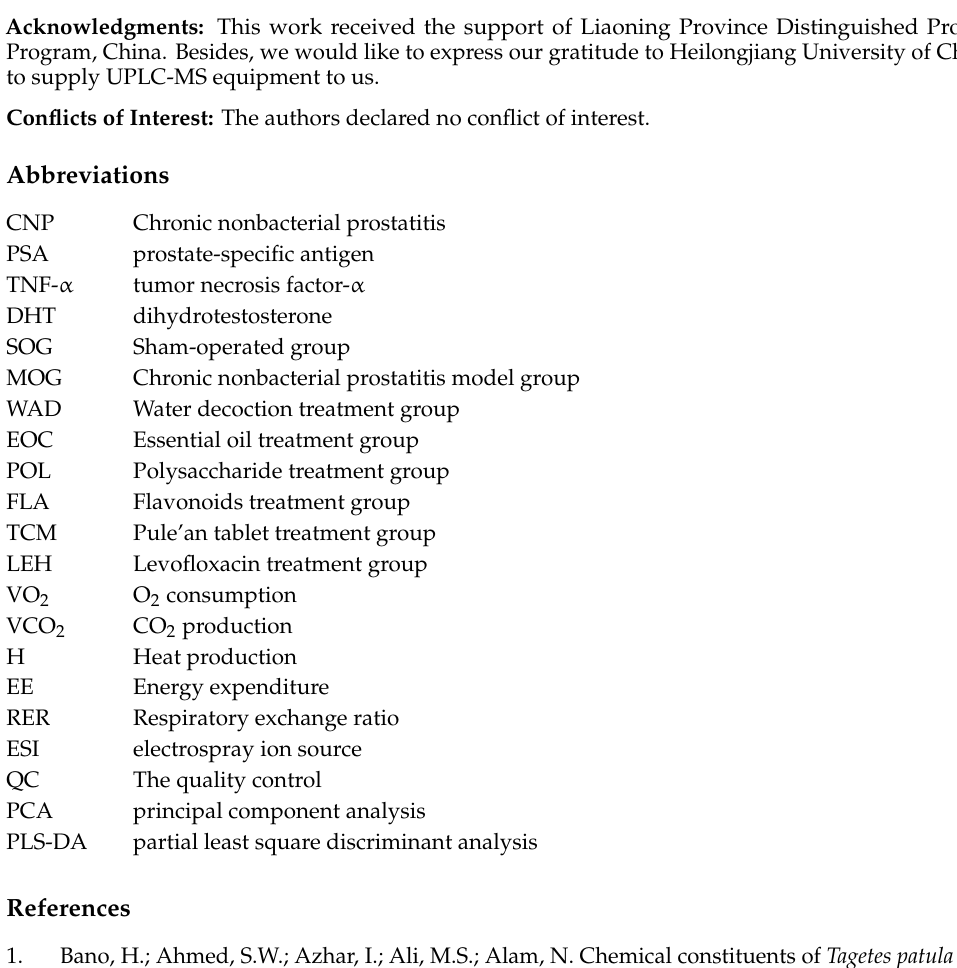
Figure S1: HPLC fingerprint of water decoction (a), supernatant (b) and essential oil (c) fractions of T. patula ., Figure S2: TIC chromatograms on positive ion mode, Figure S3: TIC chromatograms on negative ion mode, Figure S4 Histological analysis of prostate, Table S1: Potential targets of active compounds, Table S2: Relevant target genes of prostatitis, Table S3: The information of merging gene, Table S4: Details of enriched pathways, Table S5: Gradient elution program, Table S6: Markerlynx Software parameter settings, Table S7: Structures of active